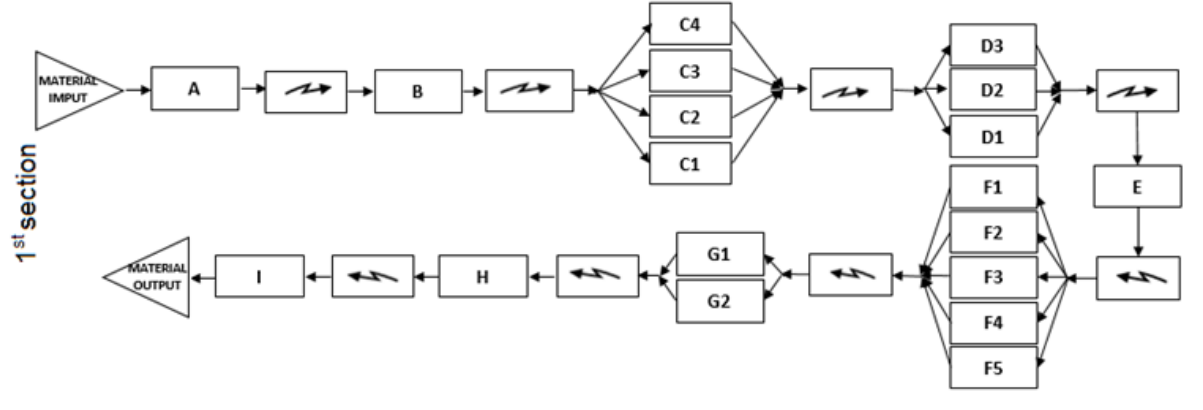
cessing. The number of operations, operation times, and the number of operators at both lines are listed in Table